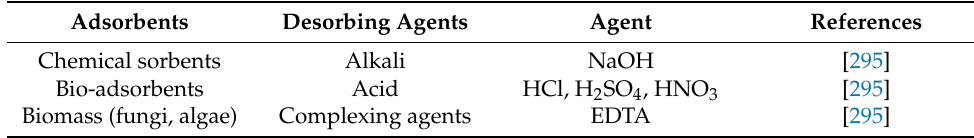
Table 14. Desorbing agents for various